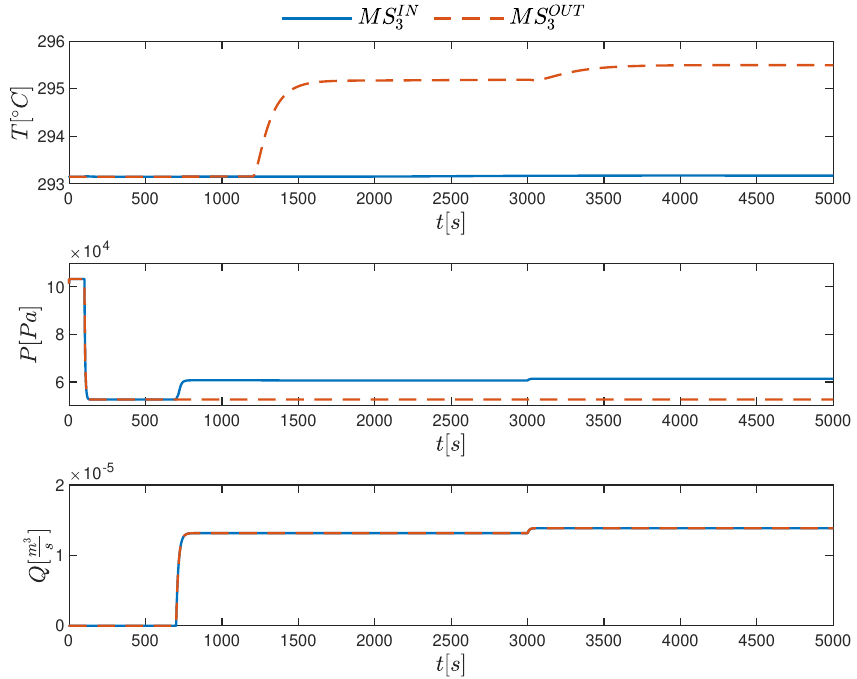
) and after the second 2